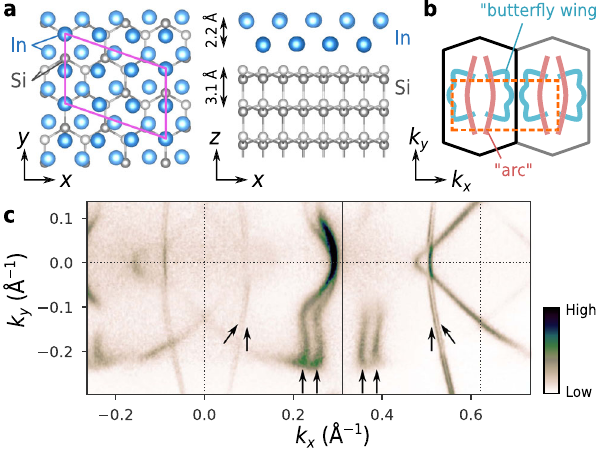
Fig. 2 Crystal structure and experimentally-observed Fermi surface. a Top view (left) and side view (right) of the crystal structure of ffiffiffi ffiffiffi p p ´ 7 3 -In. The x , y , and z axes are de fi ned to be ½ 1 (cid:1) 10 (cid:2) , ½ 11 (cid:1) 2 (cid:2) , and [111] directions, respectively. b Schematic of the 1st and 2nd Brillouin zones. The dashed box represents the area of the photoelectron intensity map in ( c ). The characteristic arc feature and butter fl y-wing feature of the Fermi surface are depicted. c Photoelectron intensity map at E F . The arrows indicate the portions of the Fermi surface with a clear